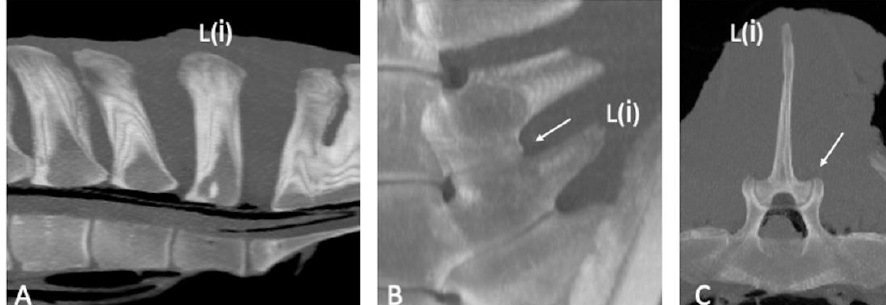
Figure 1. Sagittal (( A ); cranial is toward the left), dorsal (( B ); cranial is toward the top) and transverse (( C ); dorsal is toward the top) multiplanar reconstruction computed tomographic images of the lumbar specimen 5, using maximum intensity projection. ( A ) Presence of visible intervertebral space and absence of spondylosis, spondylolisthesis and lumbar spinous processes contact or fusion. Note the spinous process (SP) of L(i) perpendicular to the orientation of the column axis, mild irregularity of the bone surface of the L(ii) SP onto the dorsocranial aspect and contact between the S1 and S2 SPs and moderate irregularity of the dorsocaudal aspect of the S1 SP and dorsocranial aspect of the S2 SP; fusion of the ventral portion and part of the middle portion of the S1-S2 SPs ( B , C ) Regularity of the articular margins and the joint space of the L(ii)-L(i) intertransverse joint and L(ii)-L(i) articular processes joint (arrow); the L(ii)-L(i) intertransverse space is mildly narrowed on the abaxial aspect. L(i): the most caudal lumbar vertebra.